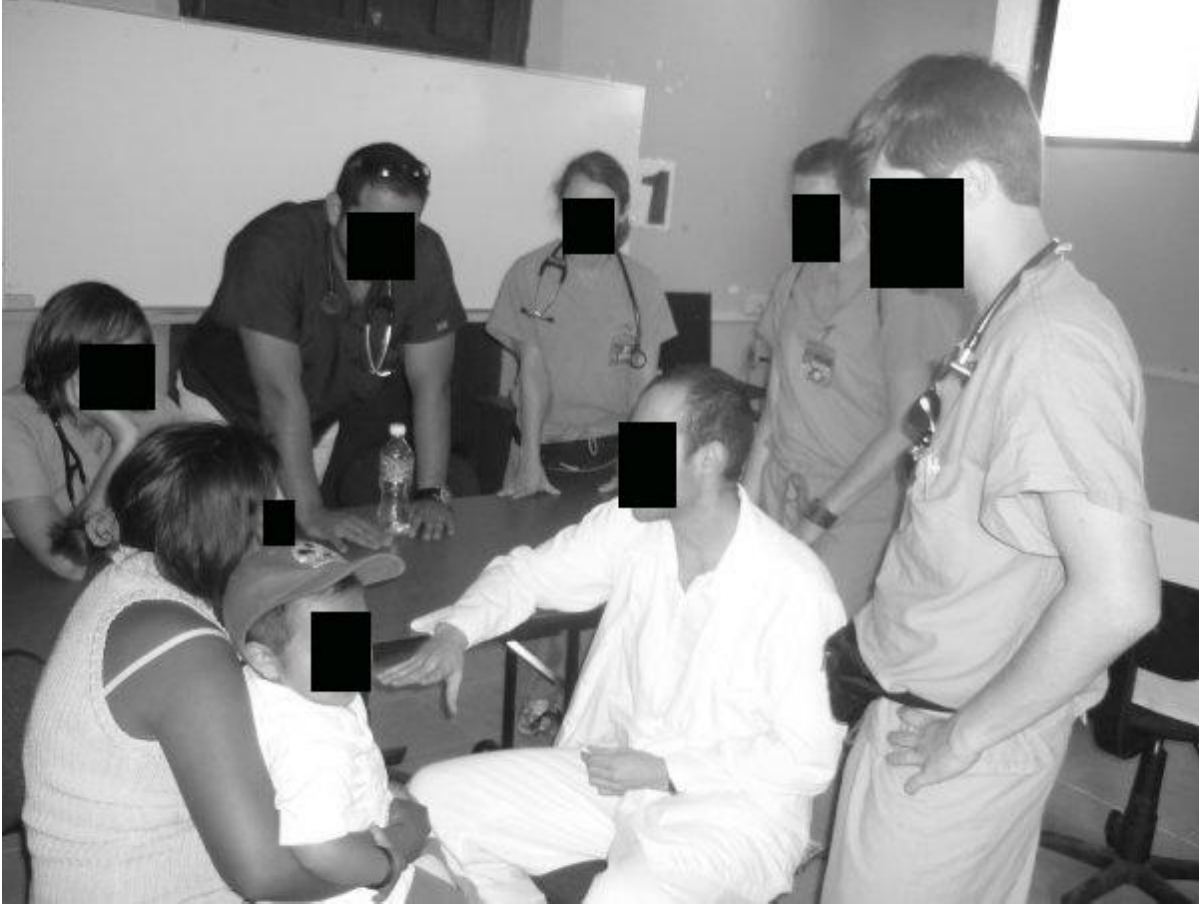
Figure 3. Example of a potential violation of patient